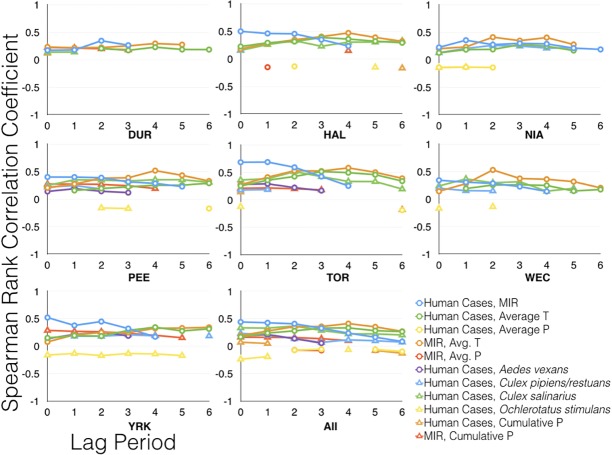
Spearman rank correlation coefficients for analyses including all years, 2002 to 2013.All, combined data from all HUs. Only significant (p < 0.05) data are presented.